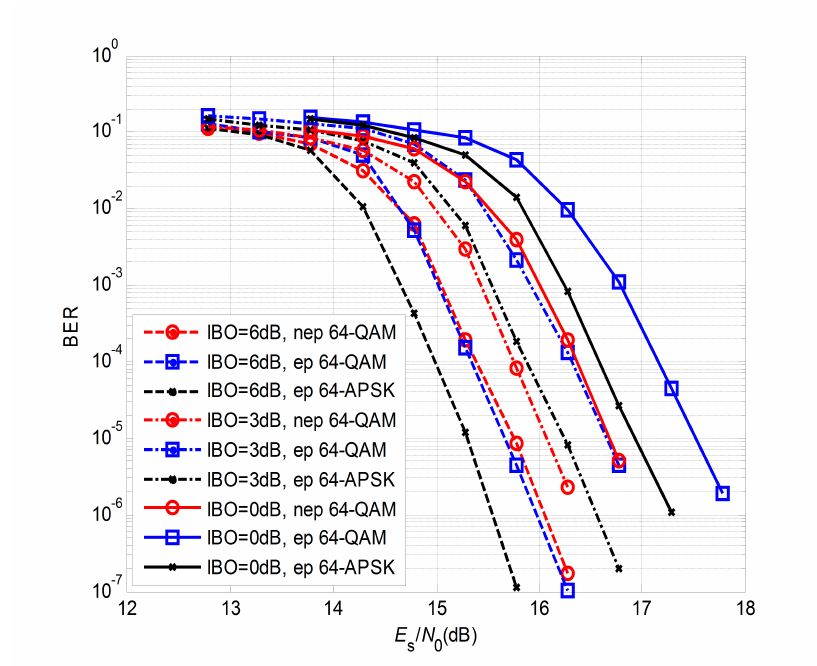
Figure 7. Bit error rate (BER) performance of different constellations over the non-linear channel at different